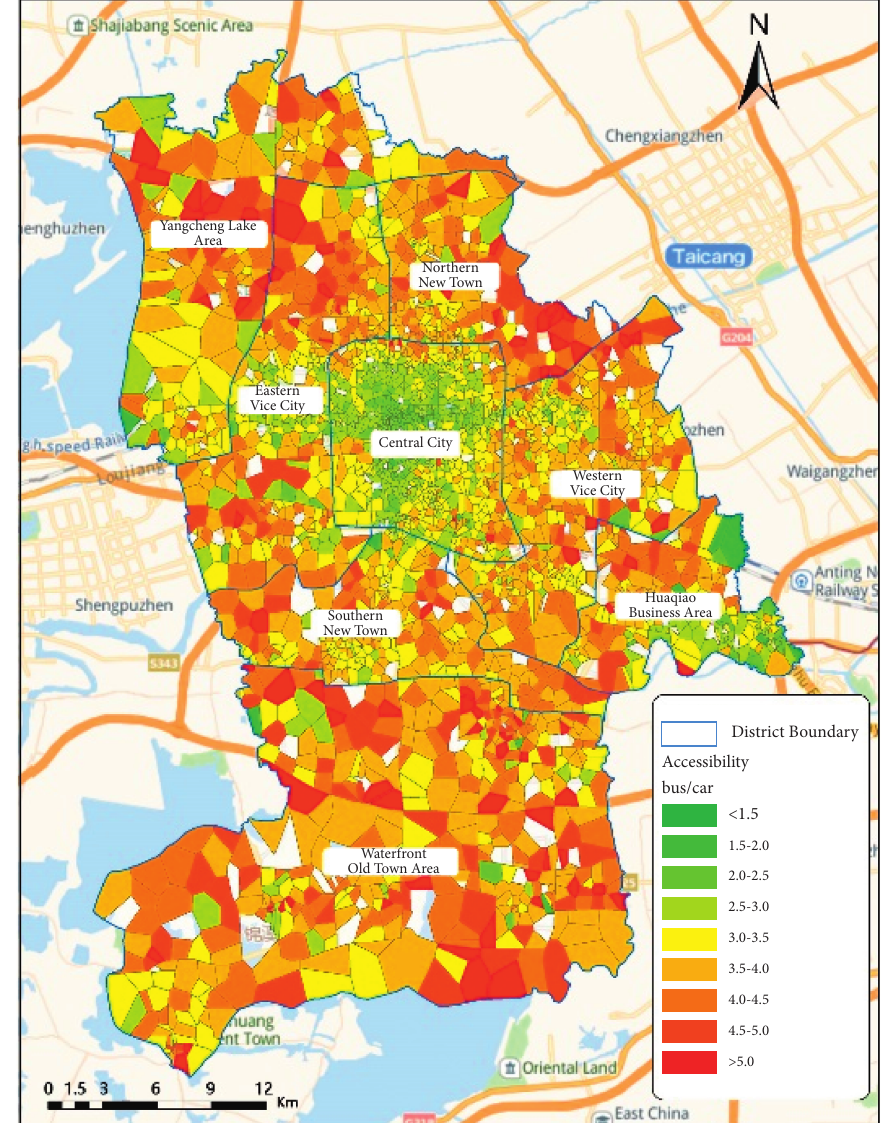
Figure 4: Accessibility